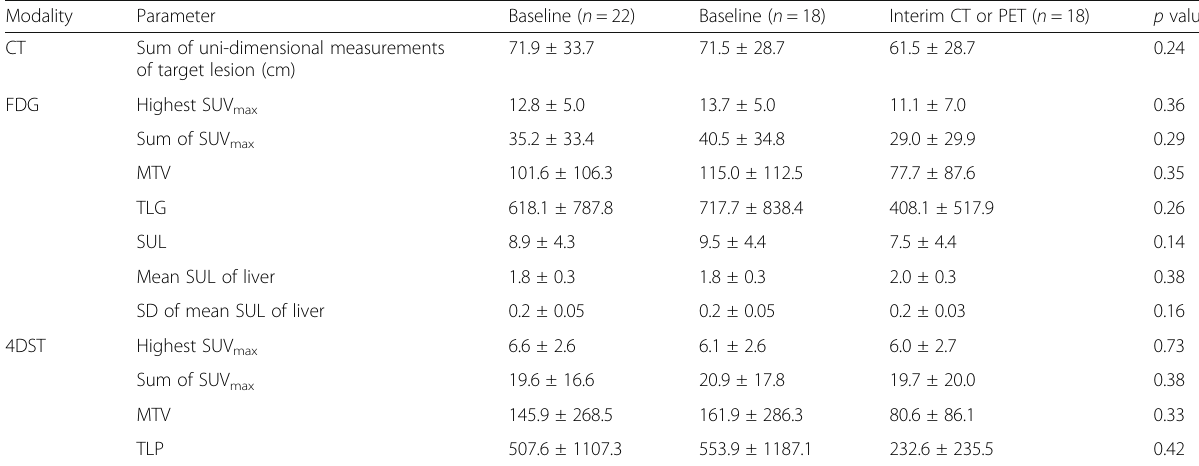
Table 2 Parameters of CT, FDG PET/CT, and 4DST PET/CT Modality